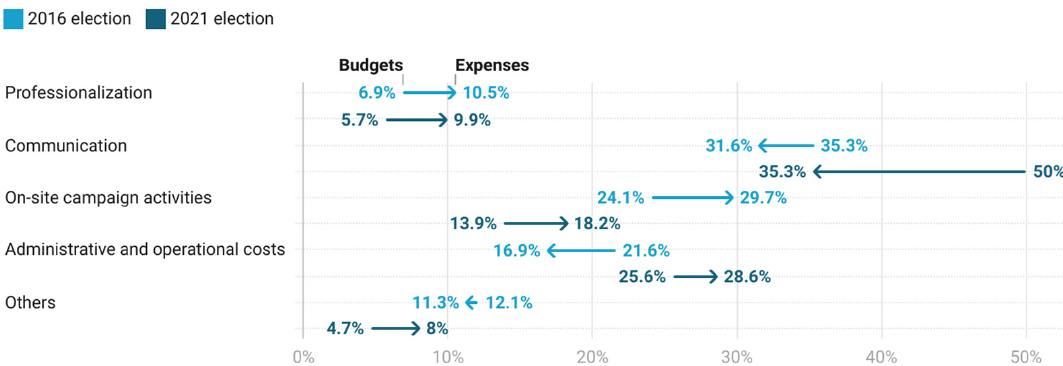
Figure 9. Investment in professionalization. Change between planned investment and actual expenses in the 2016 and 2021 Presidential elections. Source: Own coding from ECFP (https://www.tribunalconstitucional.pt/tc/contas_eleicoes-pr.html, accessed on 11 September 2022). Notes: Values at the beginning of the arrows represent budgets, while the values at the end represent expenses. Light blue arrows report to the 2016 election, while dark blue arrows to the 2021 race. Absolute values are displayed in the Appendix A (Tables A1 and A2).